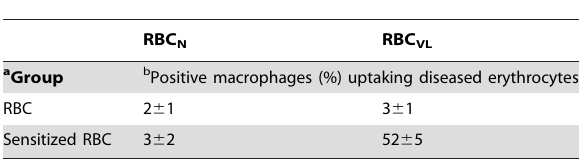
Table 2. Erythrophagocytosis